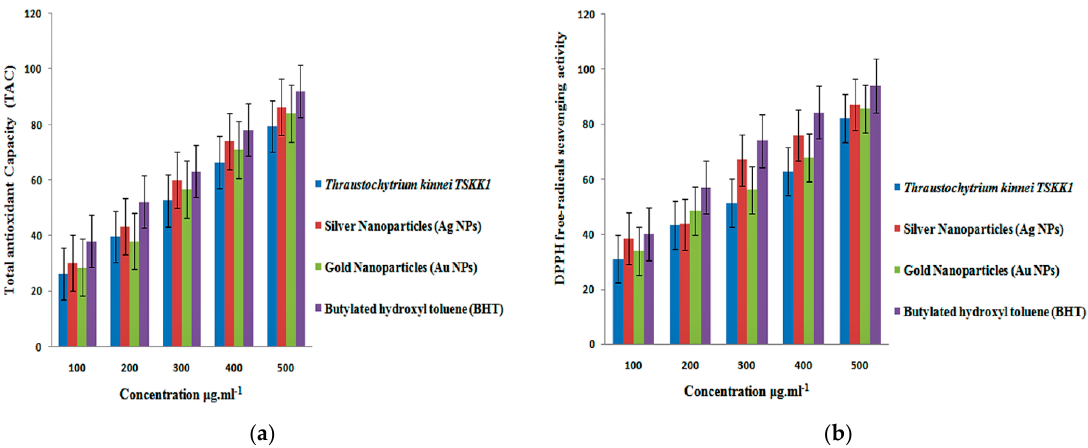
Figure 9. In vitro antioxidant activity of silver and gold nanoparticles synthesized from mangrove-derived strain Thrausto- chytrium kinnei TSKK1 at different concentrations: ( a ) total antioxidant capacity; ( b ) DPPH free-radical scavenging activity.